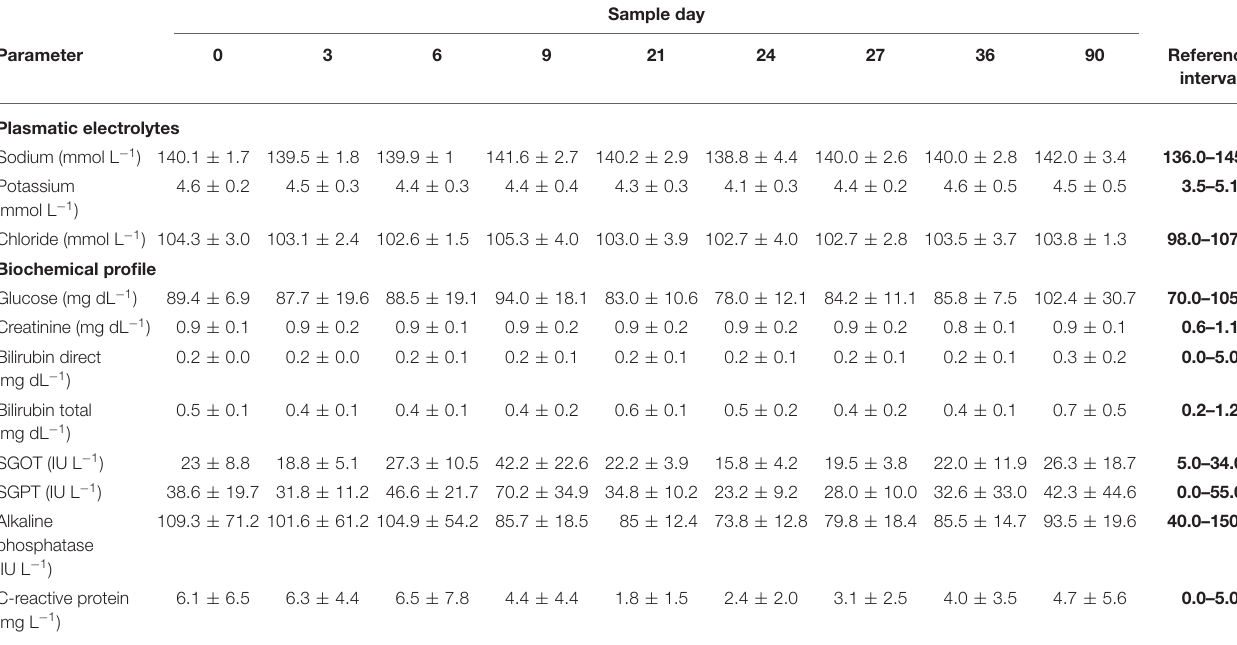
TABLE 2 | Plasmatic electrolytes and biochemical profile.